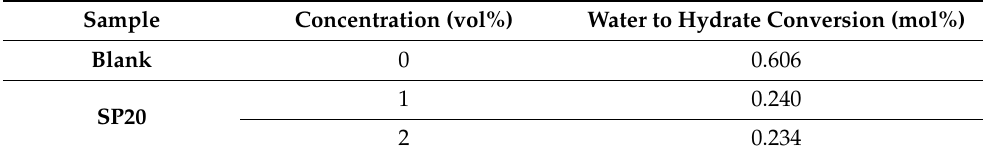
Table 2. Effect of non-ionic surfactant on the final water to CH 4 hydrate conversion activity.